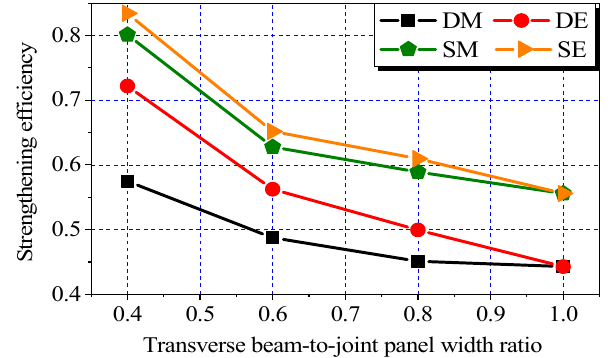
Figure 9. Effect of transverse beam-to-joint panel width ratio.